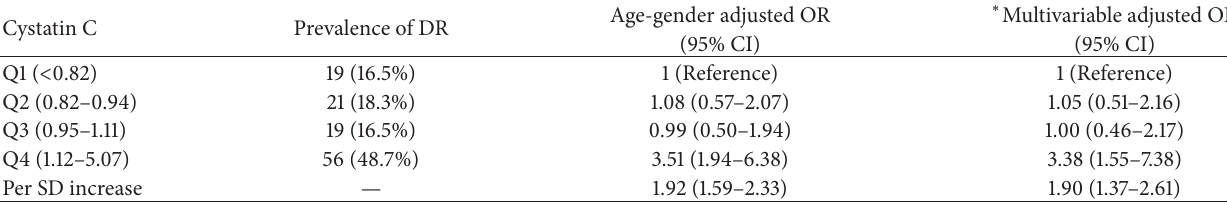
Table 4: Association between serum cystatin C and moderate